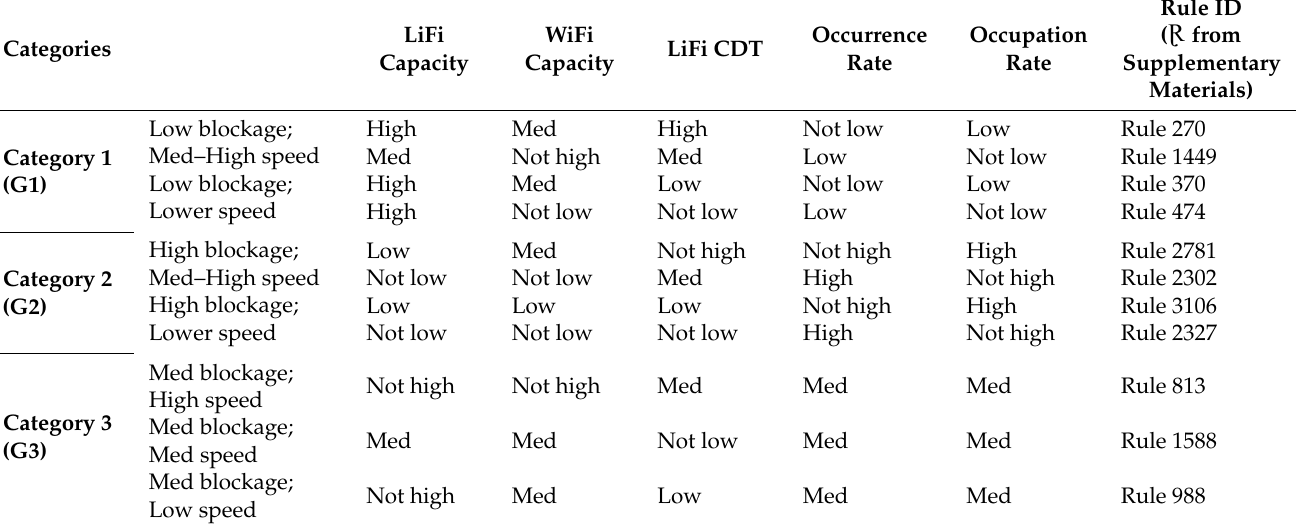
Table 4. Categories, criteria value estimations, and rules assignment.